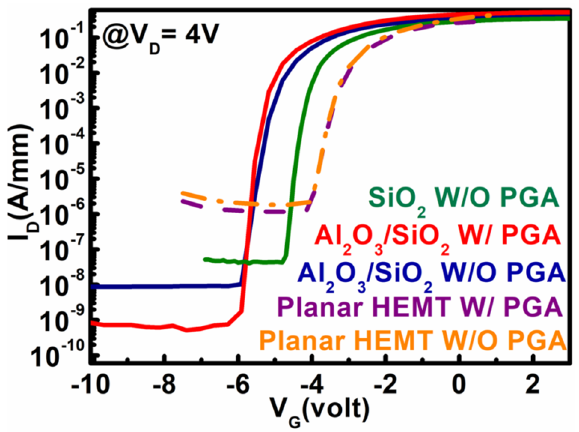
Figure 6. Subthreshold characteristics of conventional HEMT and Al 2 O 3 /SiO 2 MOS–HEMT with and without gate annealing treatment and SiO 2 MOS–HEMT without PGA treatment.